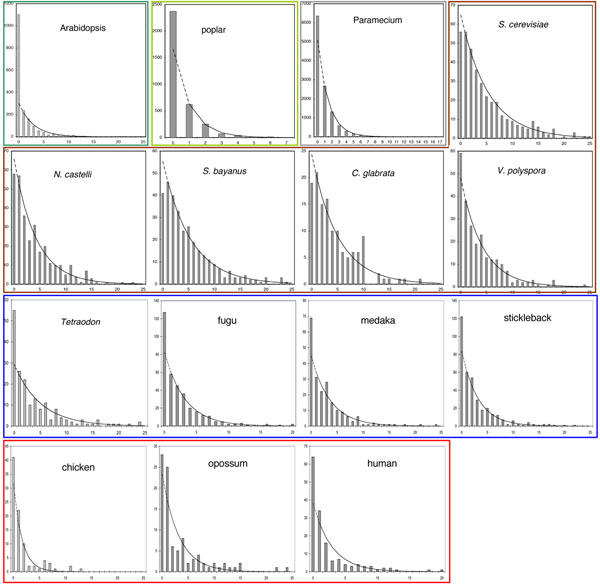
Single copy runs in 15 WGD descendants Distribution of length of run of single copy genes in 15 genomes descended from WGD events. Zero length indicates adjacent pairs of paralogs (i.e., not single-copy). Coloured boxes contain genomes descended from the same event. Frequencies of zero-length runs are not considered in the fitting by the geometric distributions shown. From [3].